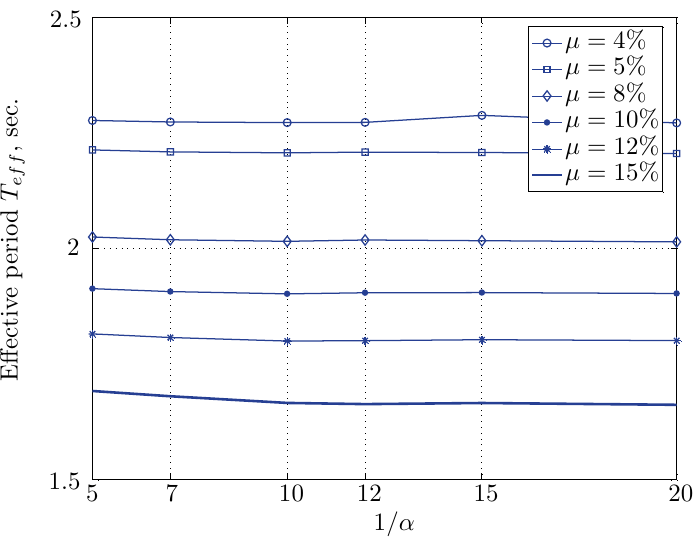
Figure 21. Effective period for various isolation system parameters (Hollister).